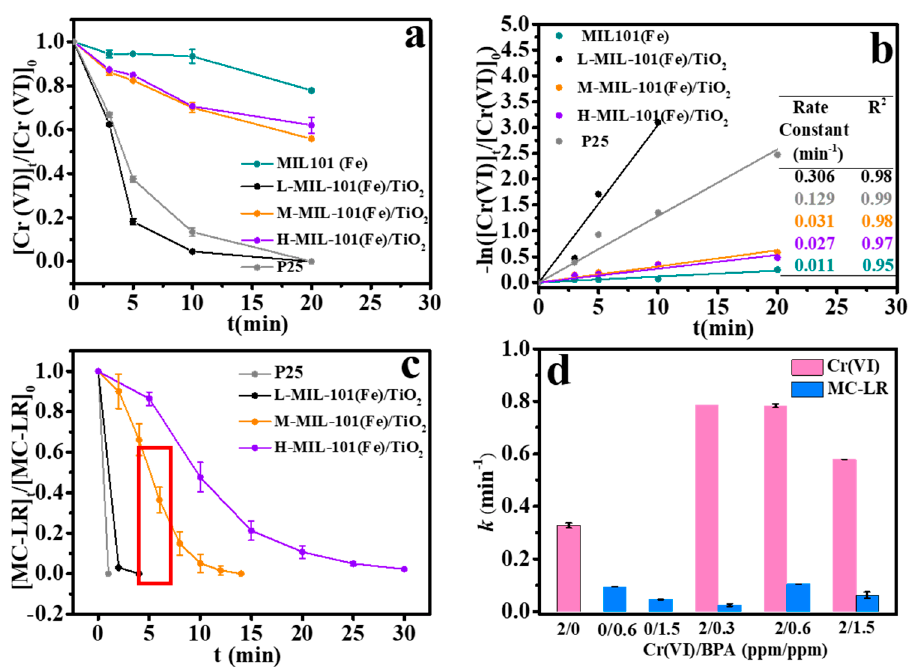
Figure 5. ( a ) Photocatalytic reduction of Cr(VI) by various photocatalysts; ( b ) the kinetics of Cr(VI) reduction by various photocatalysts; ( c ) photocatalytic oxidation of MC ‐ LR by various photocata ‐ lysts; ( d ) synergetic photocatalytic reduction of Cr(VI) and degradation of MC ‐ LR over L ‐ MIL ‐ ( d ) synergetic photocatalytic reduction of Cr(VI) and degradation of MC-LR over L-MIL-101(Fe)/TiO 2 101(Fe)/TiO 2 at different initial concentration ratios. at different initial concentration ratios.